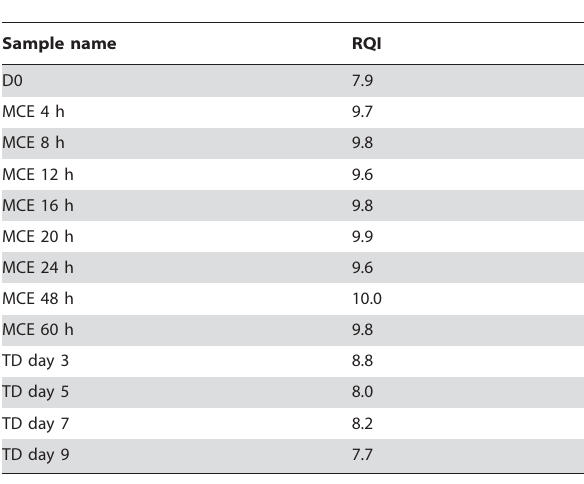
Table 3. Summary of RNA integrity analysis.